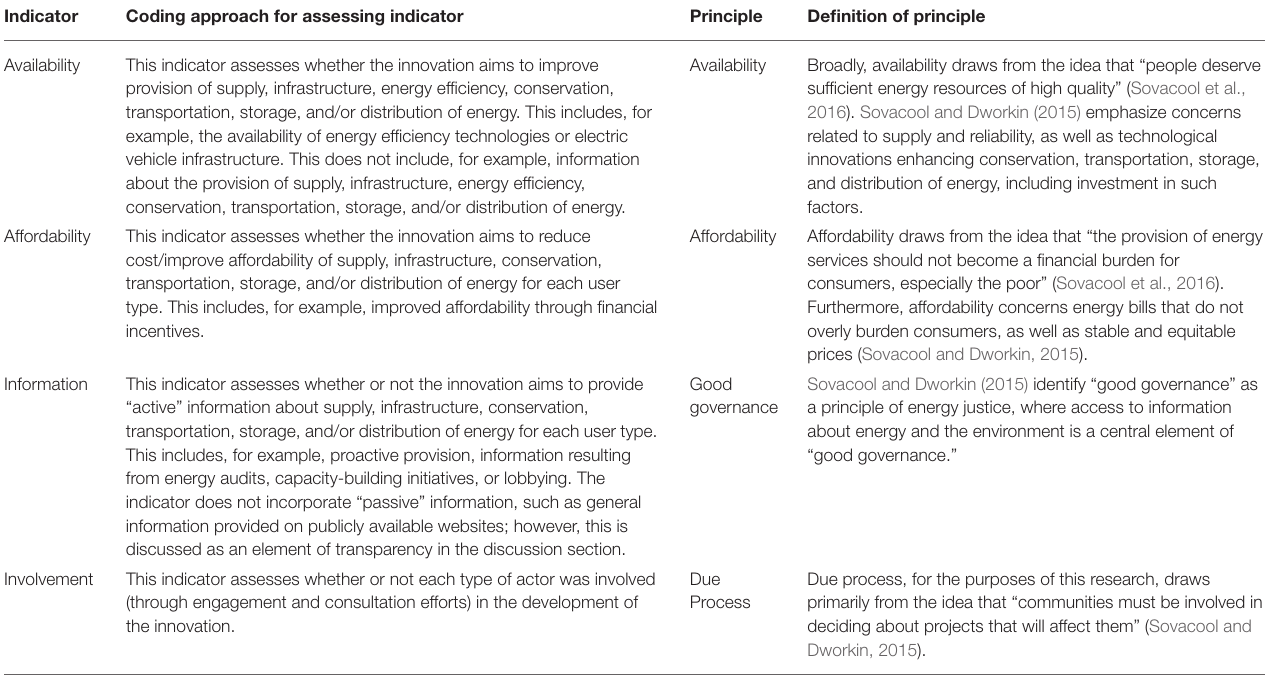
TABLE 1 | Energy justice indicators.